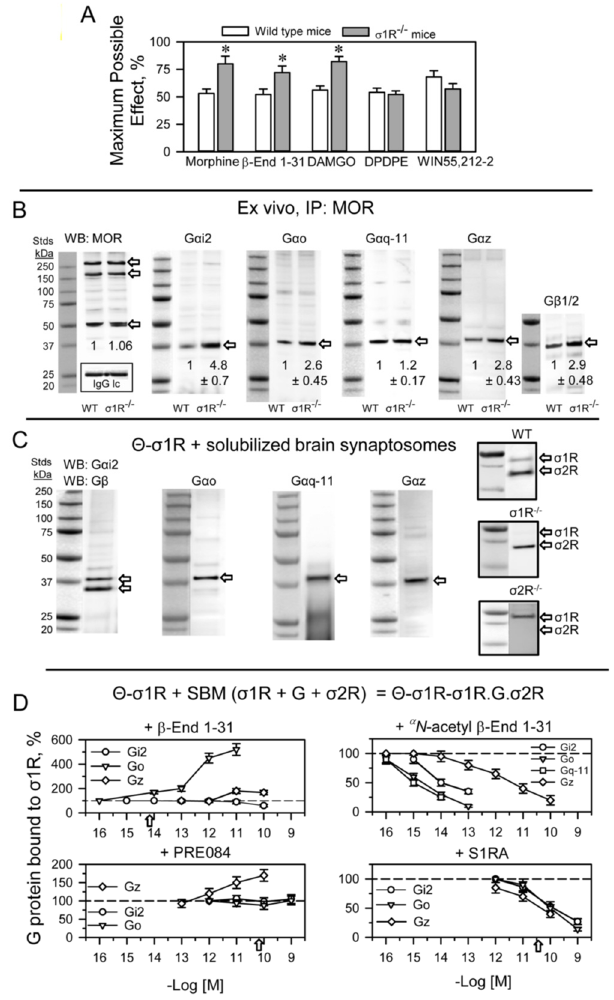
Figure 4. σ 1R binds to G proteins and regulates MOR signaling in the mouse brain. ( A ) The effect of σ 1R deletion on opioid ‐ and cannabinoid ‐ induced analgesia. Analgesic compounds were icv ‐ injected into wild ‐ type and σ 1R − / − mice, and analgesia was evaluated 30 min after morphine (3 nmol) and β‐ End 1–31 (0.5 nmol), 15 min after DAMGO (0.1 nmol) and DPDPE (10 nmol) and 10 min after WIN55,212 ‐ 2 (15 nmol). The bars are the mean ± SD of eight mice per strain and treatment. * Significant difference with respect to the effect of the analgesic substance in the wild ‐ type group. ANOVA followed by the Holm–Sidak multiple comparisons test, p < 0.05, 1 ‐β > 0.80. ( B ) Coprecipitation of G proteins with MORs. Solubilized mouse brain cortical membranes enriched in synaptosomes (SBM) from CD1 wild ‐ type (WT) and σ 1R − / − mice were solubilized with sonication in the presence of 1% NP ‐ 40. Non ‐ soluble debris was eliminated, and the samples were then incubated overnight at 4 °C with affinity ‐ purified biotinylated IgGs that were raised against extracellular regions of the MOR. Protein complexes that were immunoprecipitated with streptavidin agarose were extensively washed and then resolved by SDS ‐ PAGE. The target G proteins, alpha and beta subunits, were visualized by Western blotting (for further details, see Section 4). IP: immunoprecipitated protein, WB: Western blot. Detection of MORs: these proteins were detected with an anti ‐ MOR antibody directed to the C ‐ terminal sequence, a different amino acid sequence than that used for immunoprecipitation (second extracellular loop ‐ 2EL). In parallel blots, an antibody directed to the light IgG chain of the anti ‐ MOR antibodies used for immunoprecipitation of MORs provided a loading control for the samples in the gels. For each group, WT and σ 1R − / − , the densities of the MOR ‐ related bands indicated by the arrows, were pooled, and the computed value of the ko mice was referred to that of WT mice (assigned an arbitrary value of 1). The immunosignals of G α subunits coprecipitated with MORs were referred to those of the MORs. Data are the mean ± SD of three determinations. ANOVA followed by the Holm–Sidak multiple comparisons test, p < 0.05, 1 ‐β > 0.80. ( C ) Pull ‐ down assays using mouse SBM. Cerebral cortex fractions enriched in synaptosomes from CD1 WT mice were solubilized with RIPA buffer and incubated for 2 h with recombinant σ 1Rs covalently attached to